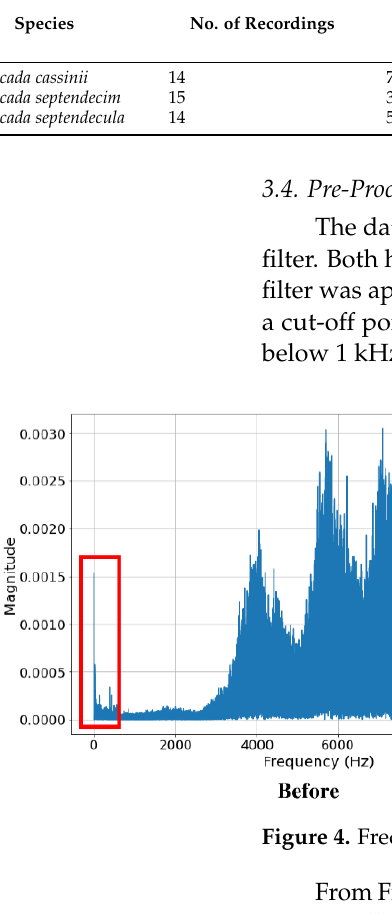
Table 1. Details of audio recordings.